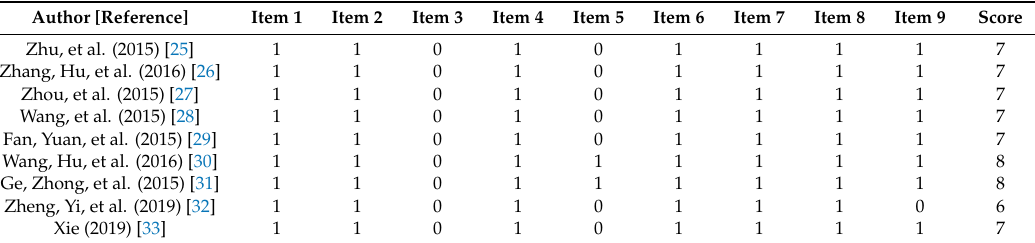
Table 2. Study quality assessment.